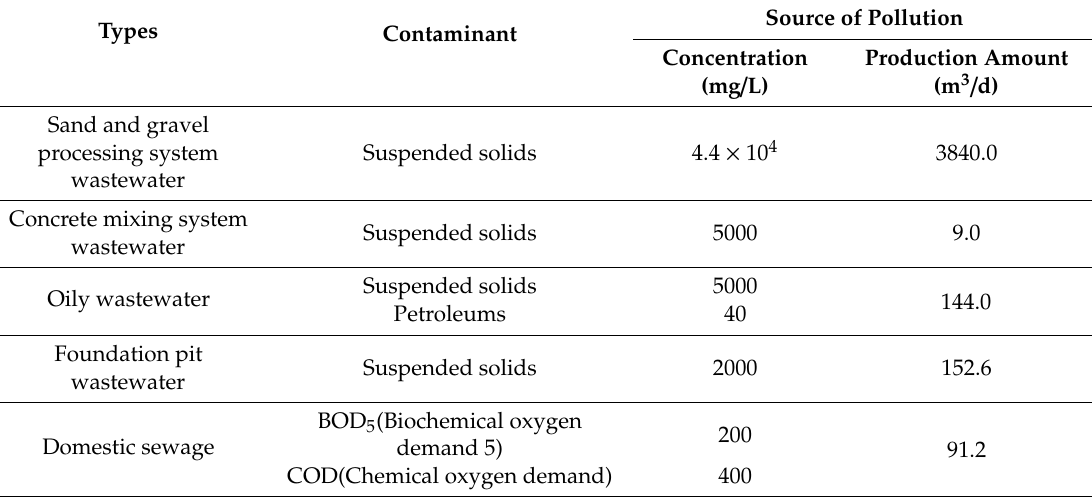
Table 3. Wastewater discharge statistics of projects during construction period (obtained from MWCP